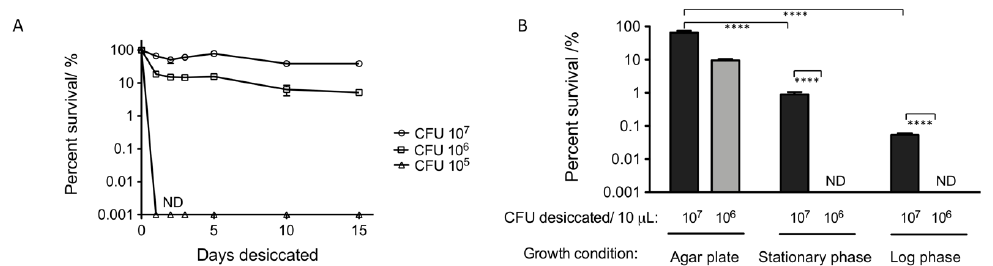
Figure 1. Growth condition and cell density influence desiccation survival of A. baumannii strain 17978. ( A ) Percent survival of A. baumannii strain 17978 desiccated over 15 days. The strain grown on an LB agar plate was harvested and adjusted to a cell density of 10 7 , 10 6 or 10 5 CFU in 10 μL of water to desiccate on polystyrene at 25 °C and 40% relative humidity before rehydration. Cells before desiccation and after 1, 2, 3, 5, 10, or 15 days of desiccation were serially diluted and spotted for CFU to determine the percent survivals. ( B ) Percent survivals of 17978 from desiccation when the strain, prior to desiccation, was grown on LB agar plates or in liquid LB to stationary phase or log phase. Bacteria from all three growth phases were adjusted to a cell density of 10 7 or 10 6 in 10 μL of water to desiccate for 48 h before rehydration. Statistical analyses were performed on the log10 transformation of the data. Percent survival comparisons were performed by two-way ANOVA with Bonferroni post-hoc test, and the p-values were presented as the stars in the graphs. **** p < 0.0001. ND marks when the percent survival was not detectable. Mean survival with error bars (SEM) was obtained from 3 replicates for (A) and 4 replicates for (B).